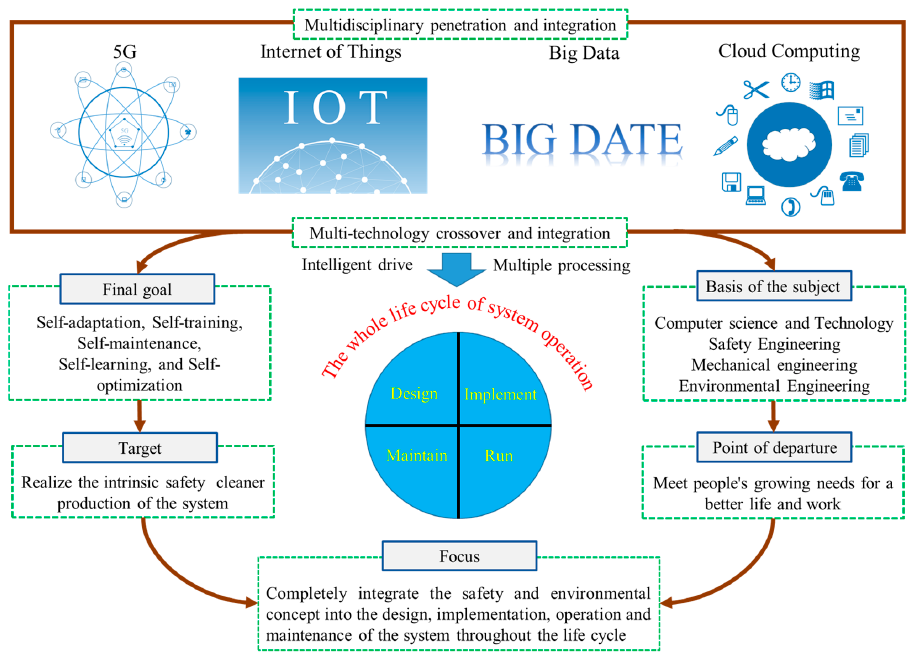
Figure 3. The realization tools, basis of the subject, and point of departure, focus, target, and final goal of ISE.